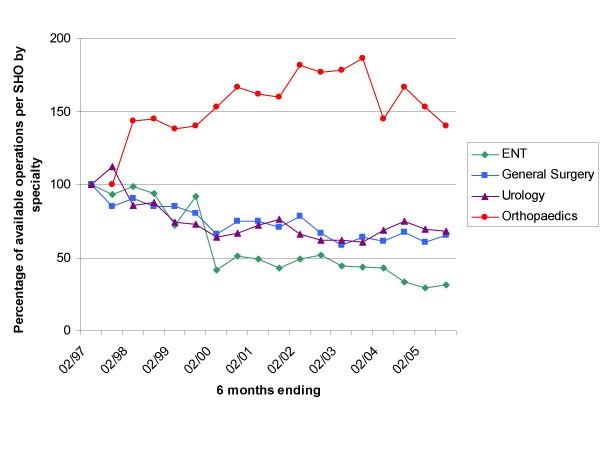
Changes in operations available per trainee by specialty.